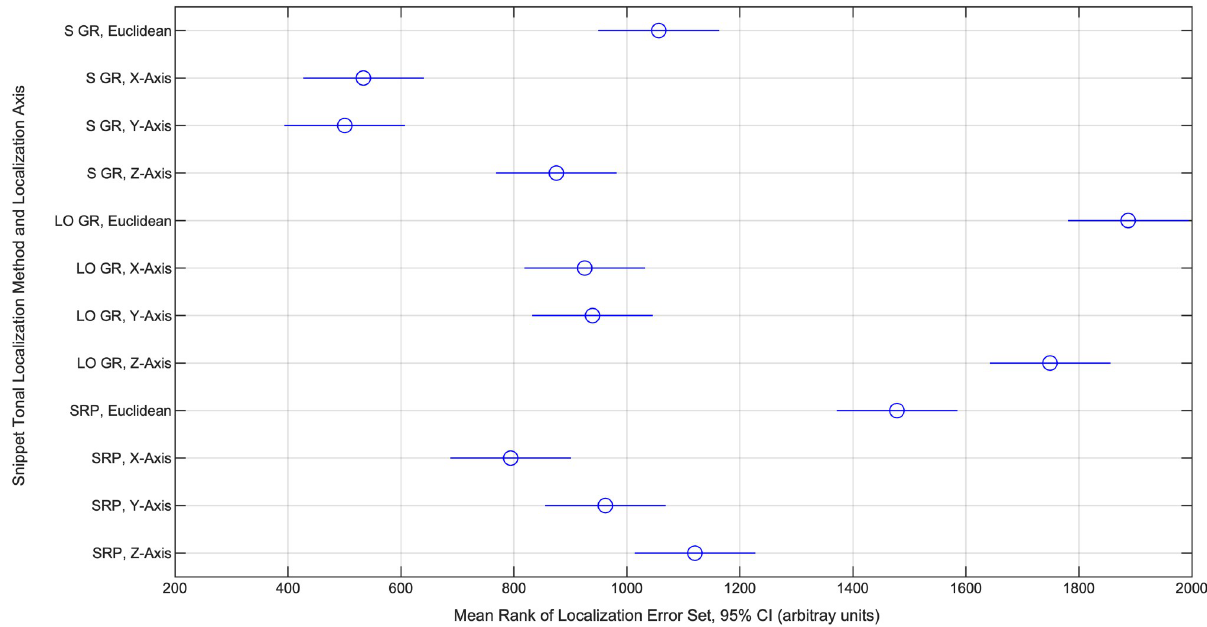
Fig 7. Mean ranks of test set source coordinate prediction error sets (3 methods x 4 axes). The mean ranks for the localization error (absolute deviation) sets belonging to every source localization method and axis of localization, computed ahead of a Kruskal-Wallis test, are shown with 95% CI’s. Based on Dunn’s tests with an overall 5% significance threshold, overlapping intervals reflect sets whose underlying distributions are not statistically distinct (implying non-distinct MAD’s); non-overlapping intervals reflect sets that are distinct (implying distinct MAD’s).